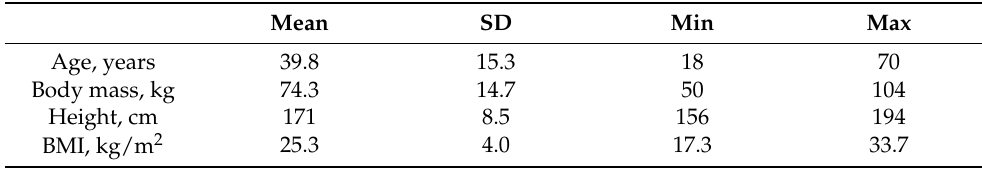
Table 1. Clinical characteristics of the studied patients.